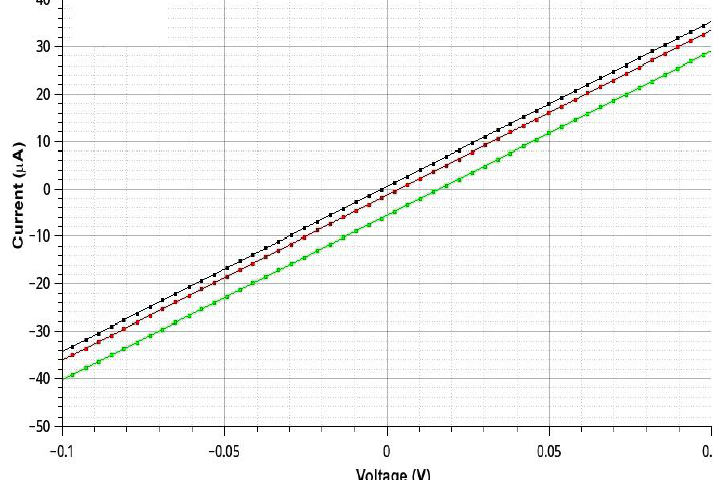
Fig. 5. The current-voltage characteristics of the nanowire at various values of the amplitude of the voltage at input IDT: 0.7V (black), 2.3V (red), 7.5V (green). This work was partially supported by Russian Science Foundation grant #18-49-08005 in frame of development of hybrid acoustonanosensor and by Russian Foundation of Basic Research grants #19-07- 01091-a and 18-29-23042-mk in frame of development of technology for production of nanostructures